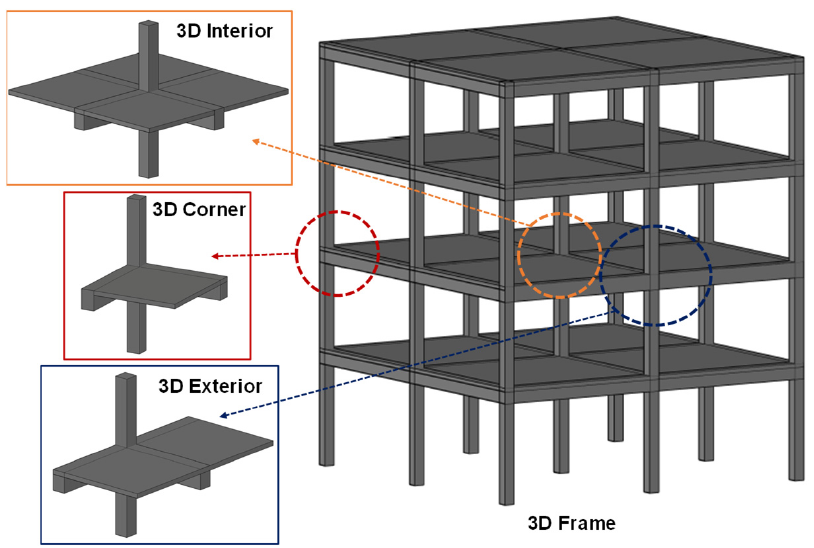
Figure 3. Beam–column joint configurations possible in the middle story of a 3D RC frame.